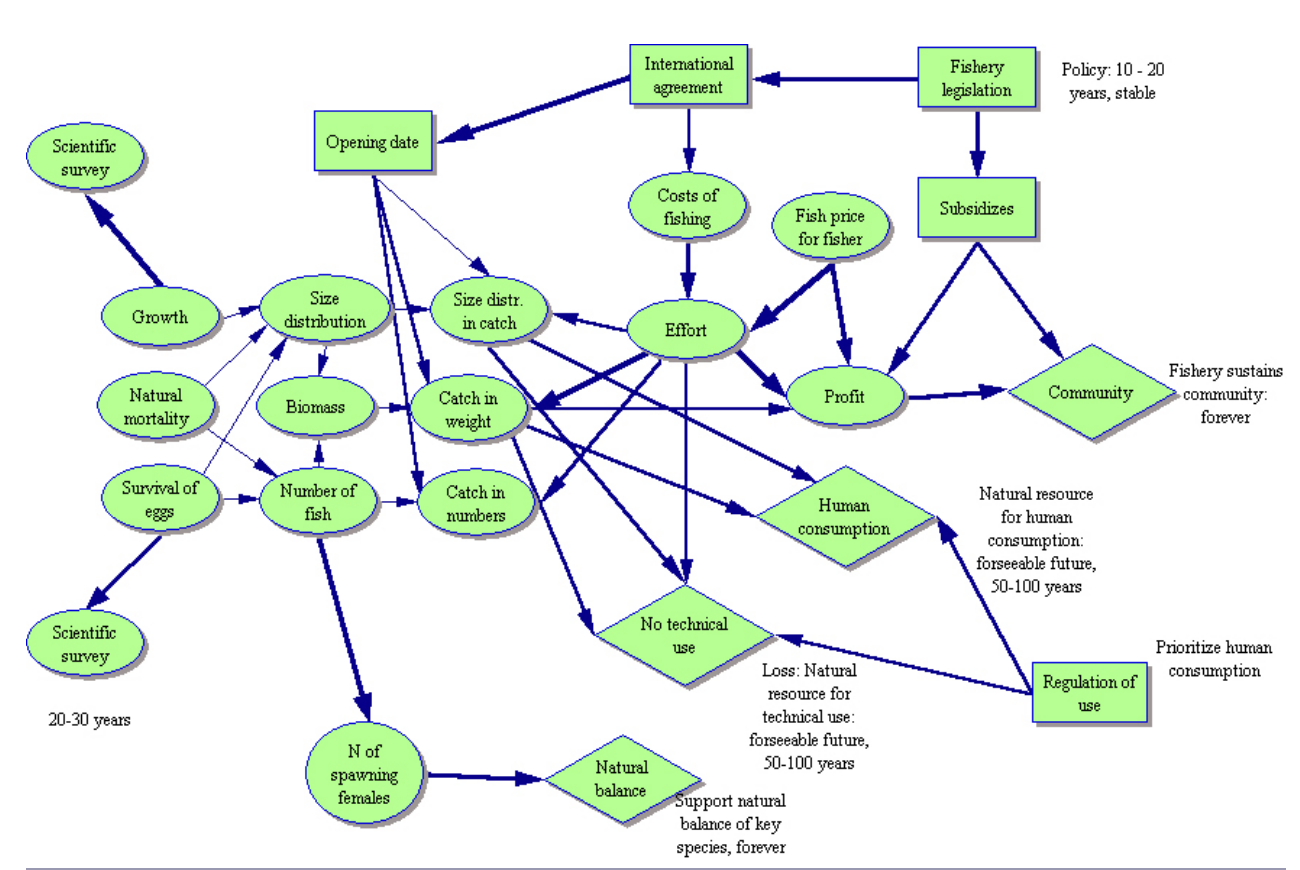
Fig. 3. The ENGO representative’s